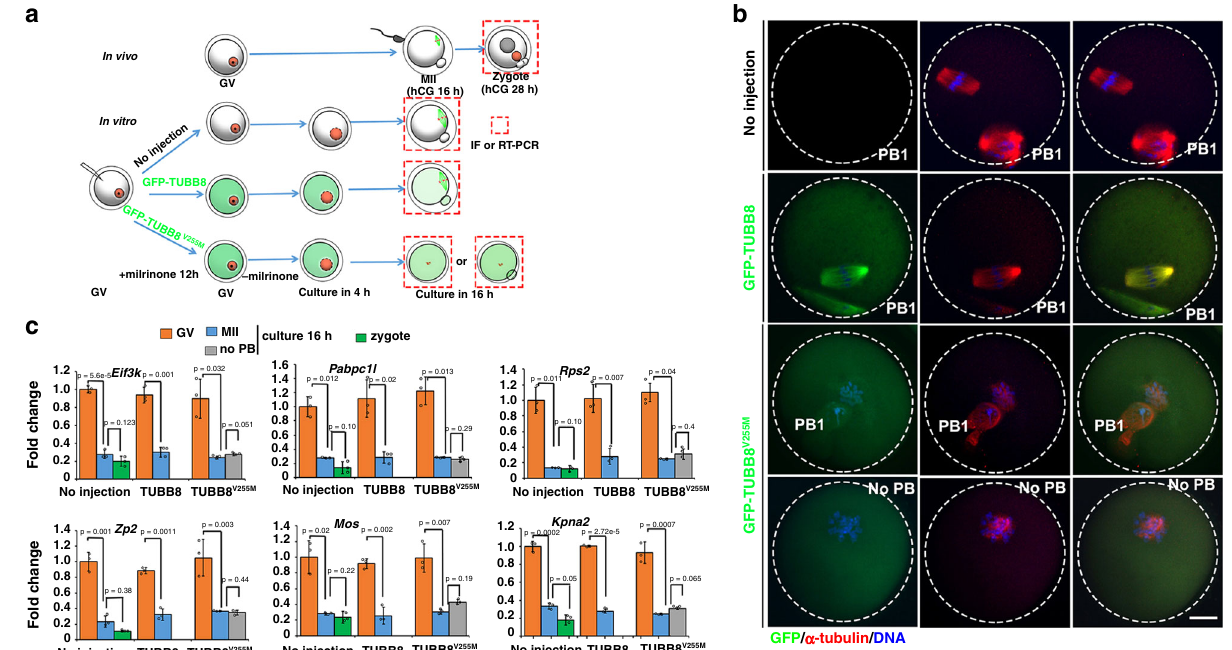
Fig. 4 TUBB8 mutation did not affect M-decay in mouse oocytes. a A diagram of spindle assembly disruption after microinjection of mRNAs encoding GFP-TUBB8 V255M . b Confocal microscopy results showing spindle assembly of mouse oocytes at 16 h after meiotic resumption. GV oocytes were microinjected with mRNAs encoding either wild type or mutant (V255M) TUBB8 and then cultured, as shown in a . Endogenous α -tubulin was detected by immuno fl uorescence (red). DNA was labeled by 4 ’ ,6-diamidino-2-phenylindole (DAPI). Scale bars = 20 µ m. The immunostainings were independently repeated for three times with similar results. c RT-qPCR results showing the relative levels of M-decay transcripts in mouse oocyte microinjected with mRNAs encoding wild type or mutant (V255M) TUBB8, as shown in a . Levels of these transcripts were also detected in normal zygotes as controls. n = 3 biological replicates. Data are presented as mean values± SEM. P by two-tailed Student ’ s t -tests. n.s. non-signi fi cant, No PB no polar